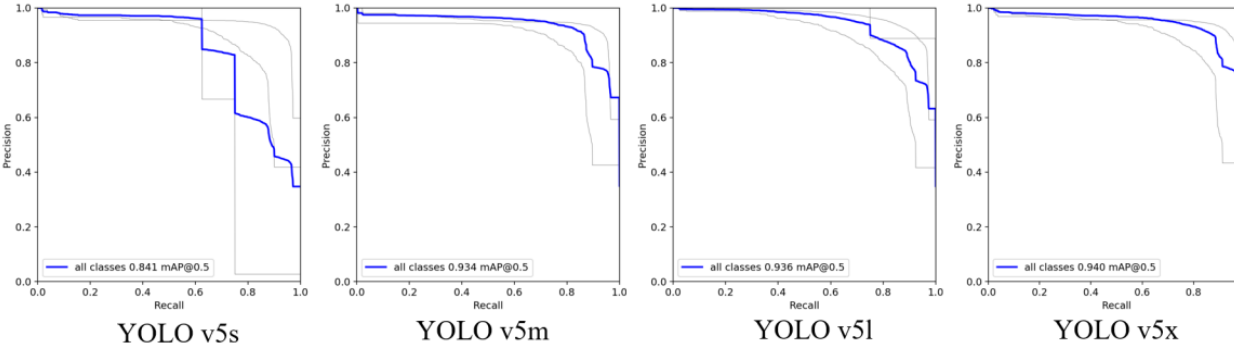
Figure 10. P-R curves of the four models during the training.